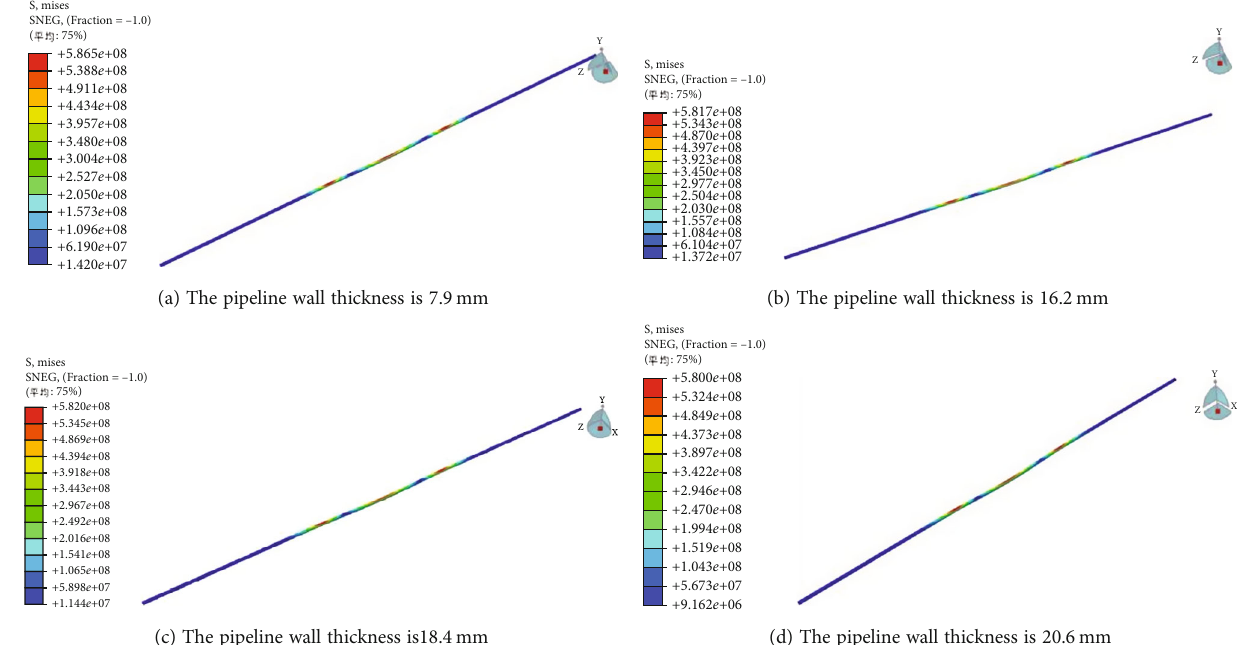
Figure 16: The pipeline stress under di ff erent pipeline wall